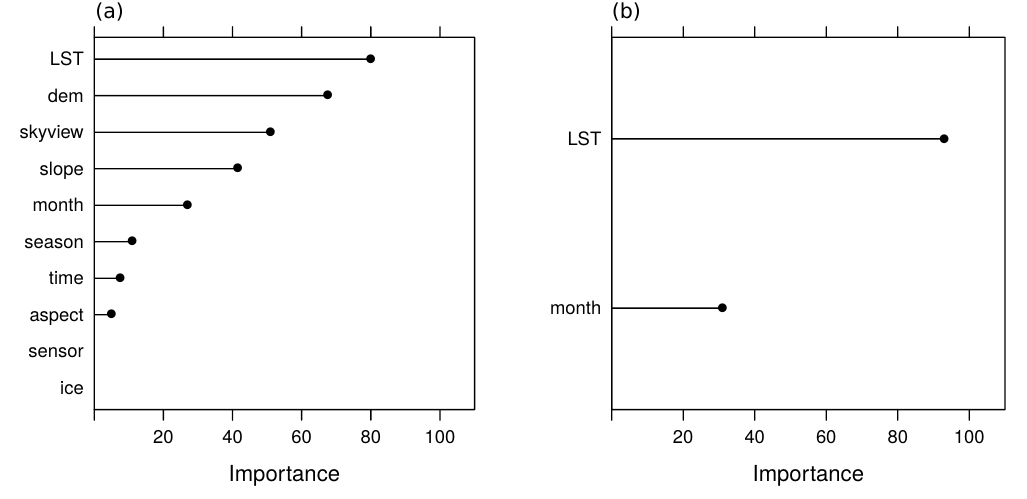
Figure 2. Relative variable importance revealed by Cubist for ( a ) the full model and ( b ) the model that used variables selected during forward feature selection only. Variable importance was estimated as the percentage of times each variable was used in the model